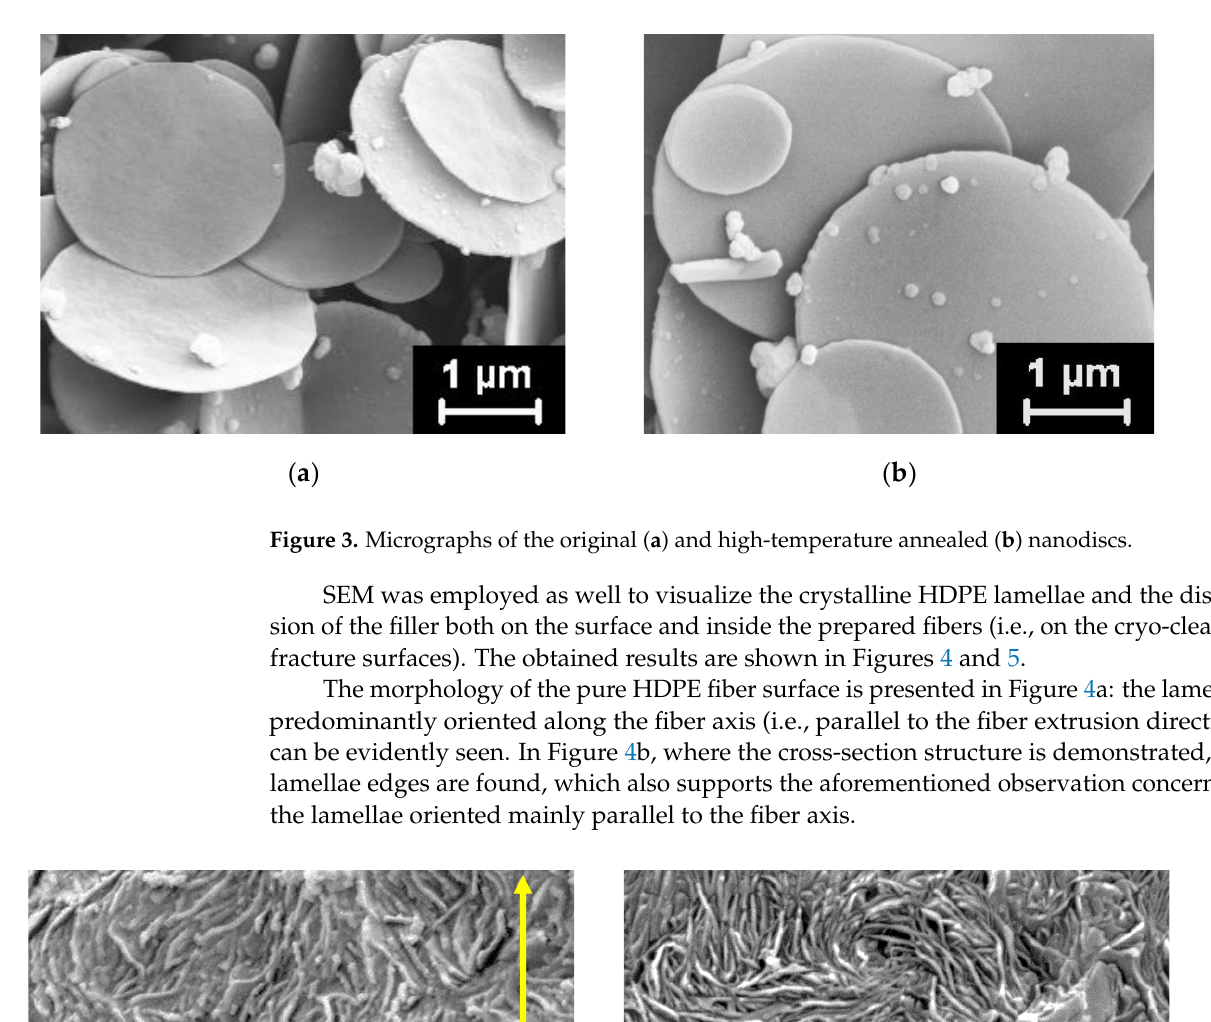
Figure 3. Micrographs of the original ( a ) and high-temperature annealed ( b ) nanodiscs.